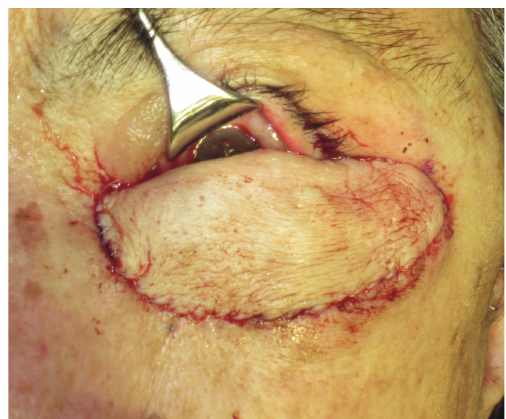
Figure 4: An elliptical skin graft approximately 5 × 8cm was removed from the right underarm and was sutured over the